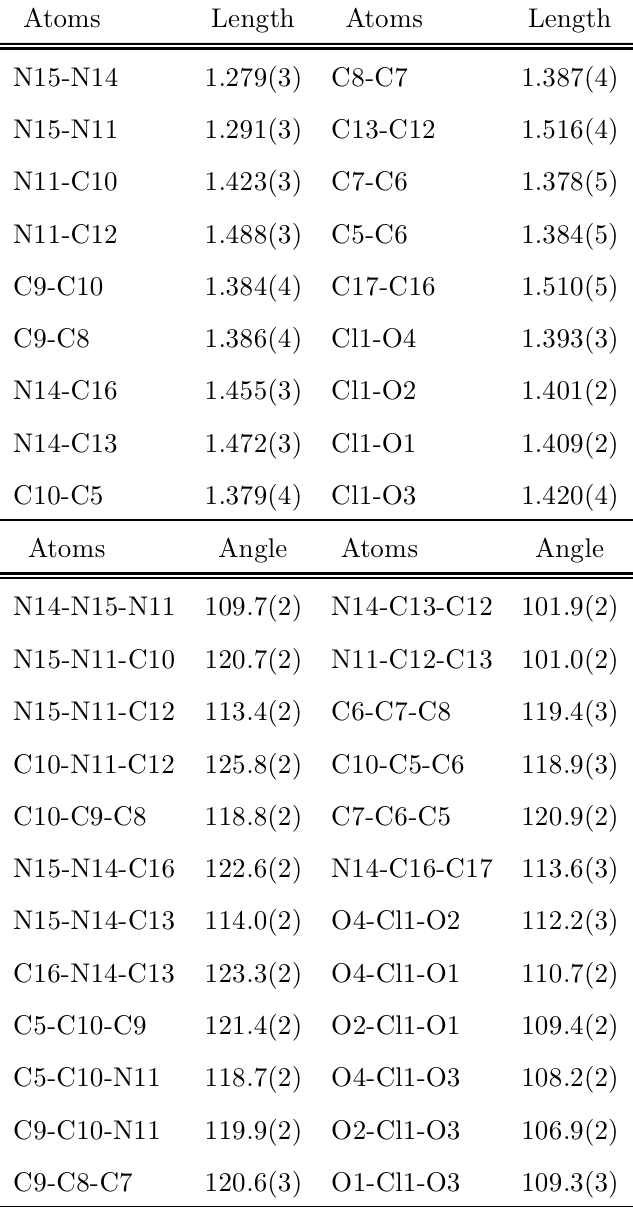
Table 4 Bond Lengths (¸A) and Bond Angles ( ¯